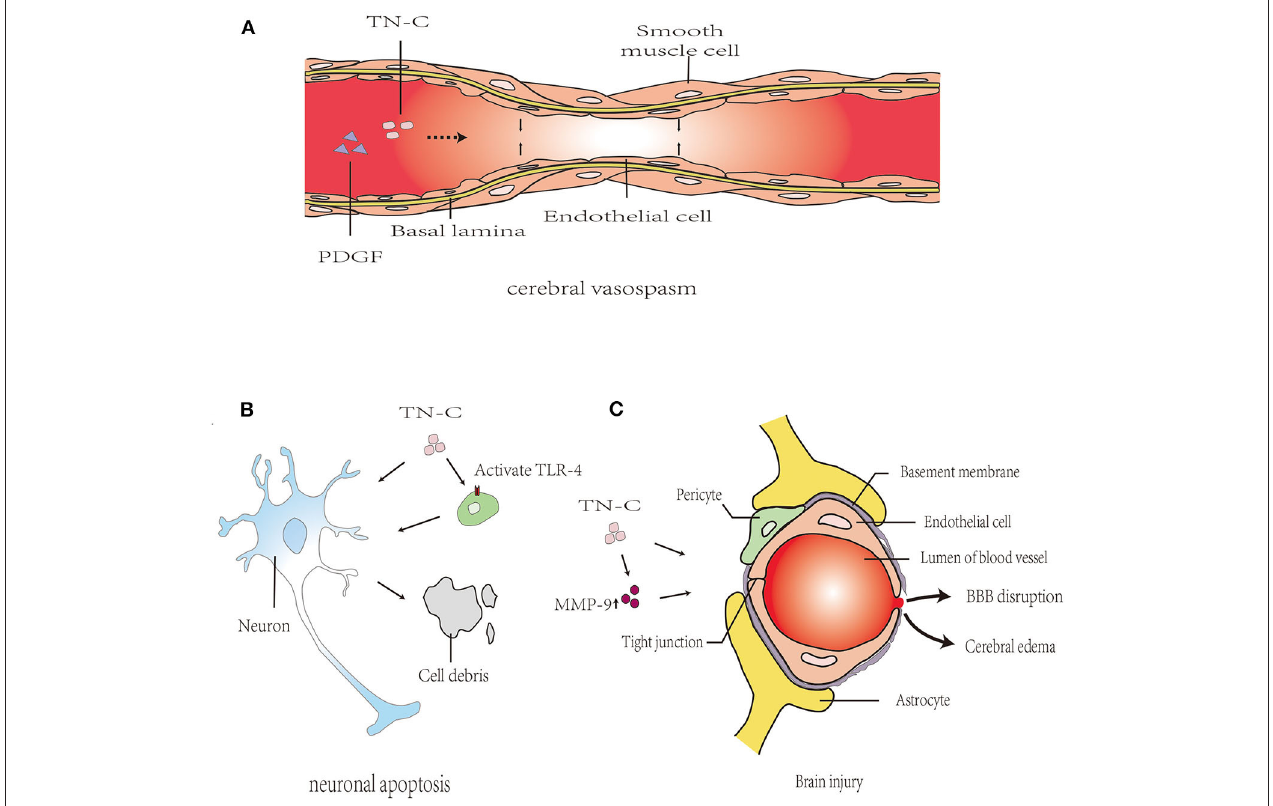
FIGURE 4 | Proposed mechanism of TN-C in post-SAH brain injury. (A) : TN-C induced cerebral vasospasm after SAH via the upregulation of PDGFR- β . (B) : TN-C-induced neuronal apoptosis, partly mediated by TLR4/NF- κ B/IL-1 β pathways. (C) : TN-C induces brain edema and BBB disruption following SAH. PDGF, platelet-derived growth factor; PDGFR, platelet-derived growth factor receptor; BBB, blood–brain barrier; MMP, matrix metalloprotein; ZO, zonula occludens; JNK, c-Jun N-terminal kinase; ERK, extracellular regulated protein kinases; PI3k, phosphatidylinositol 3-kinase; MAPK, mitogen-activated protein kinase; TLR4, Toll-like receptor